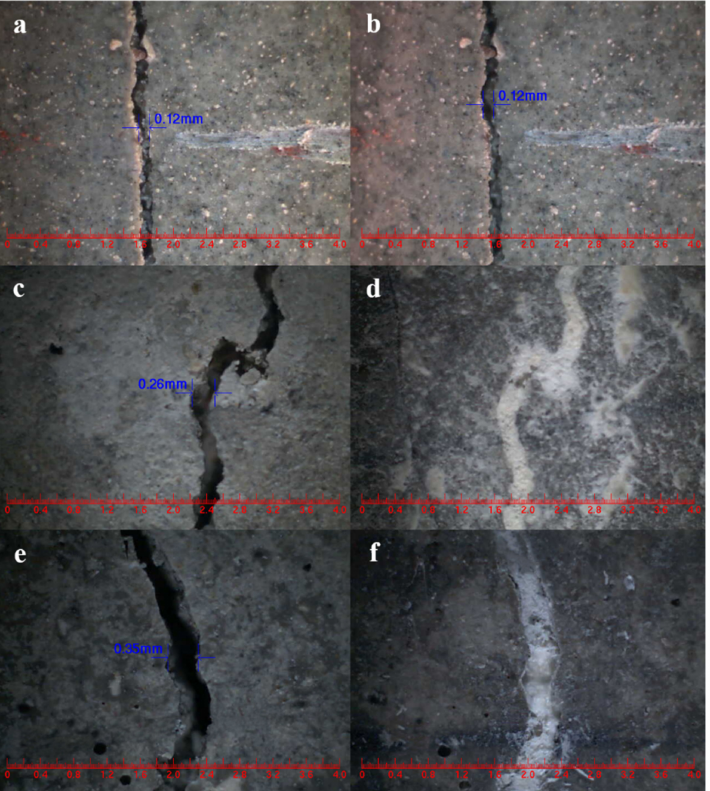
Figure 13. Surface crack self-healing of mortars. ( a ) CCM0 before self-healing, ( b ) CCM0 after 3 days of self-healing, ( c ) CCM1 before self-healing, ( d ) CCM1 after 3 days of self-healing, ( e ) CCM2 before self-healing, ( f ) CCM2 after 3 days of